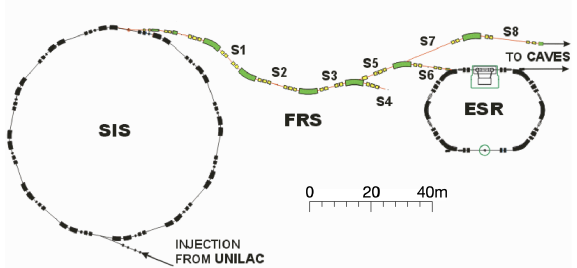
Figure 1. Schematic drawing of the SIS18 synchrotron and the fragment separator (FRS) at GSI.